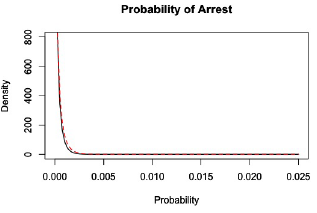
Figure 2. Distribution of the probability of obtaining heroin. The black line represents the density of success probability across all customers within each 1-hour interval of market activity, based on 100 simulations of the market from days 180 to 365. The dashed red line represents a fitted distribution, which is a Beta (0.835,0.718) distribution.